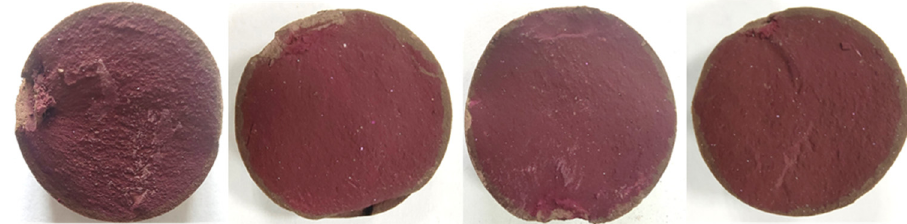
Figure 10. Corroded appearance of cement sample.